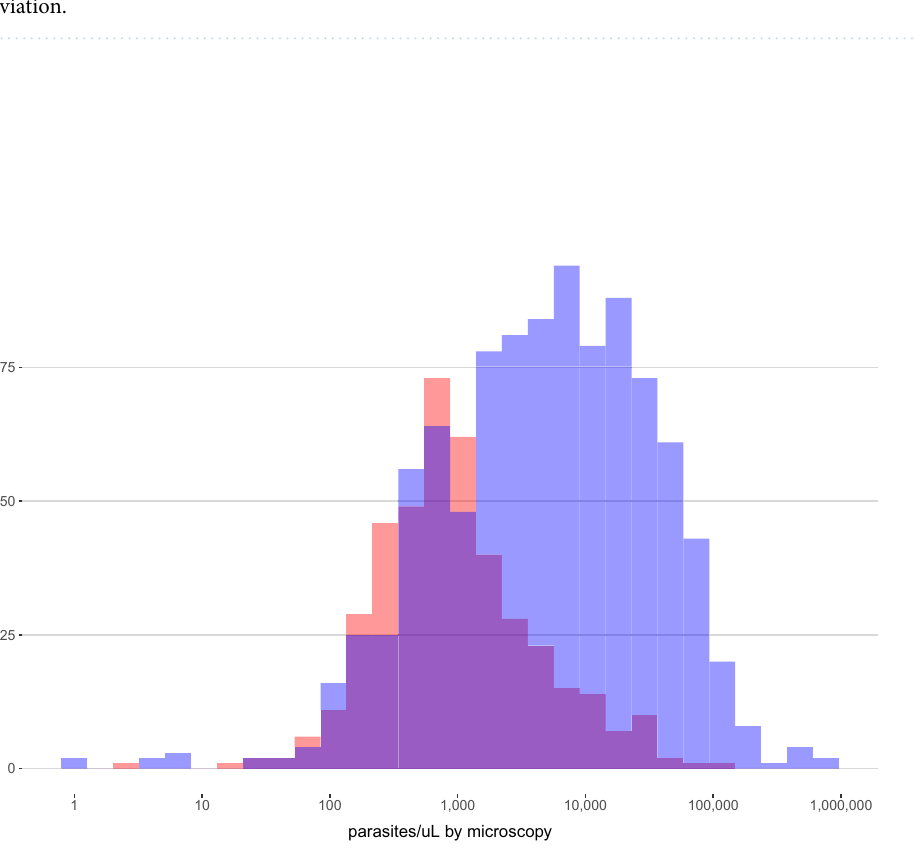
Table 1. Characteristics of enrolled study subjects. Kruskal–Wallis and one-way ANOVA p-values are included for province-wise comparisons. IQR interquartile range, RDT rapid diagnostic test, SD standard deviation.